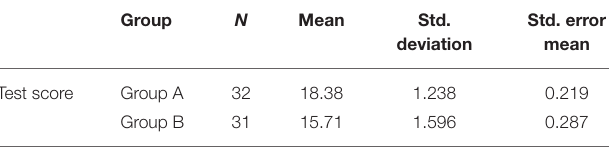
TABLE 5A | Descriptive statistics after the